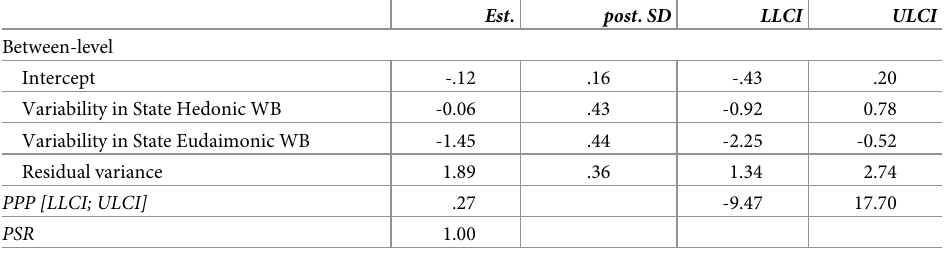
Table 3. Multilevel Structural Equation Models predicting mean daily levels of state extra-role performance from intra-individual variability in state eudaimonic well-being.